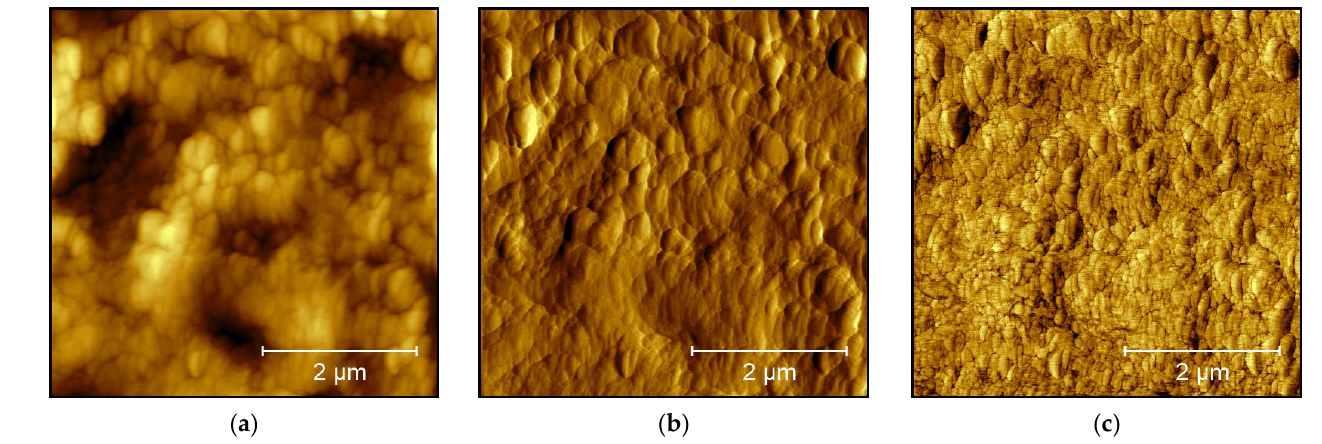
Figure 9. AFM images of a 3D printed PLA “UV” surface: ( a ) topography (height range 1.2 µm); ( b ) amplitude; ( c ) phase image (phase range 77°).